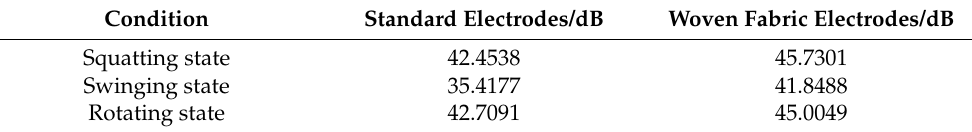
Table 2. SNR of the woven fabric electrodes and standard medical electrodes in various